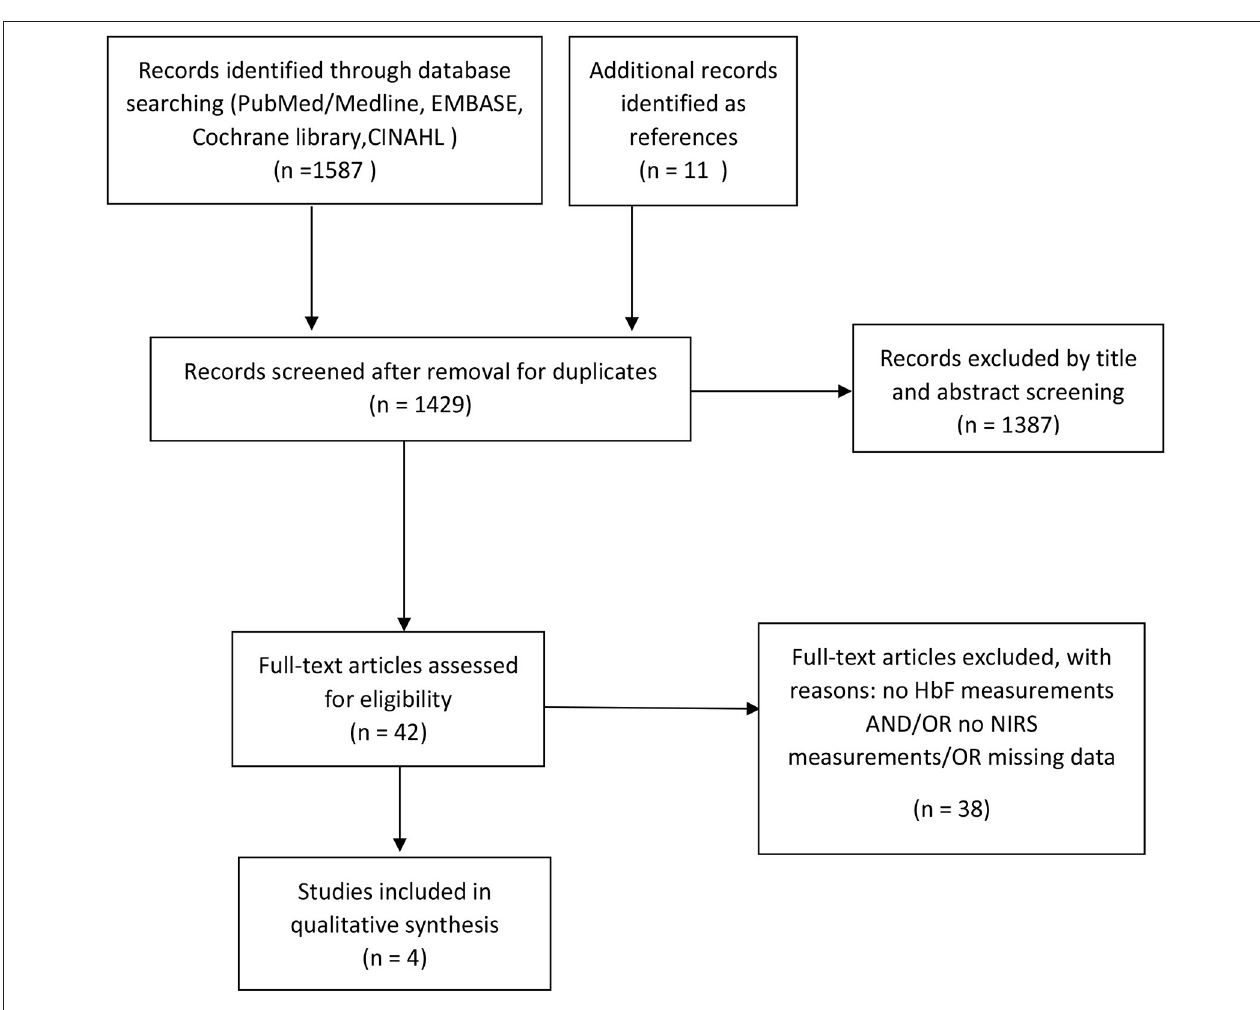
FIGURE 2 | Study selection flow diagram according to the PRISMA